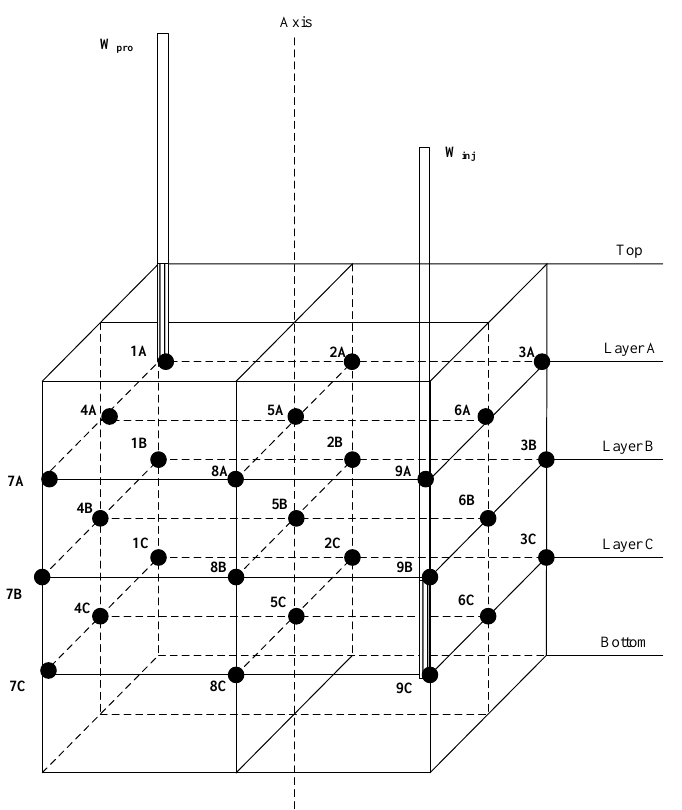
Figure 2. Temperature measuring points and wellhead distribution.